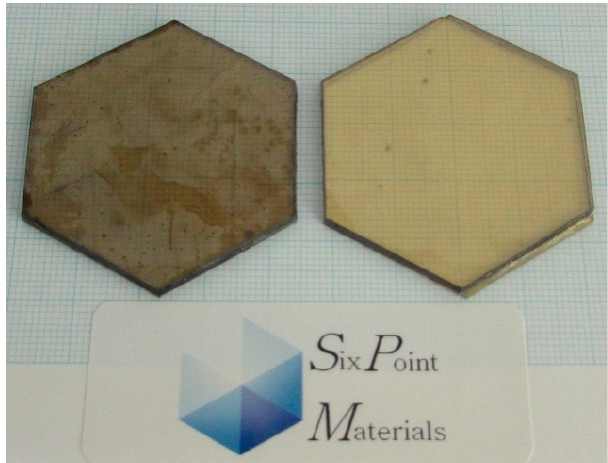
as reported previously [23].